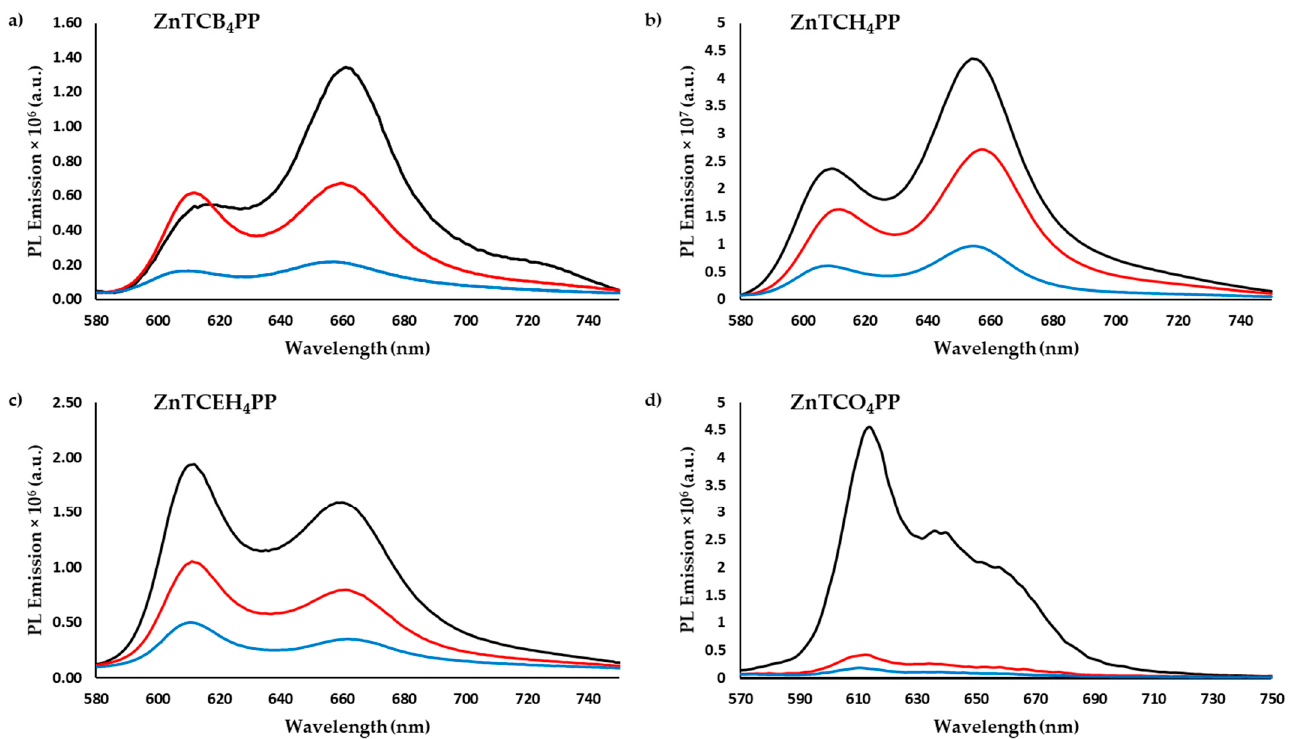
Figure 3. Photoluminescence emission spectra of spin-cast metalloporphyrins thin films of ( a ) butyl derivative—ZnTCB 4 PP, ( b ) hexyl derivative—ZnTCH 4 PP, ( c ) 2-ethylhexyl derivative—ZnTCEH 4 PP and ( d ) octyl derivative—ZnTCO 4 PP. Each plot includes spectra of pristine films ( - ), films doped with v frac 0.06% ( - ) and films doped with v frac 0.2% ( - ).